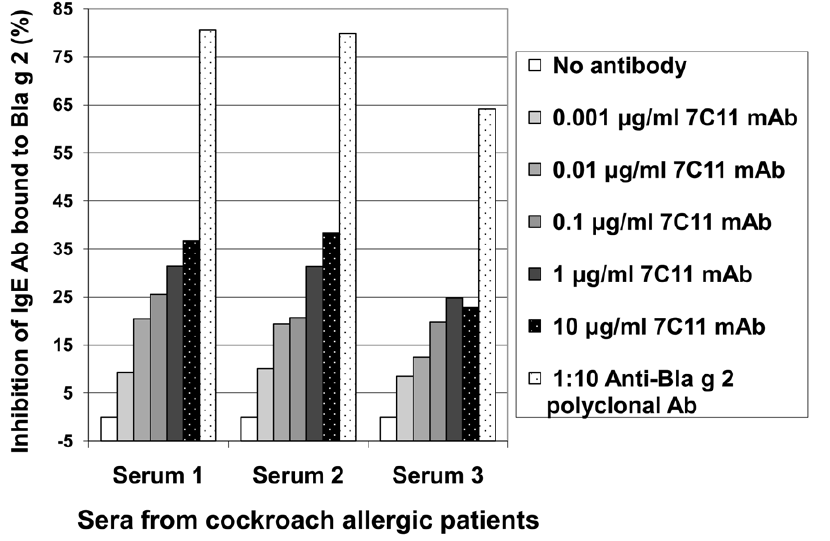
Figure 1. Overlap of 7C11 mAb and IgE antibody epitopes. Inhibition of IgE antibody binding to Bla g 2 by mAb 7C11 (0.001–10 m g/ml) and a rabbit anti-Bla g 2 polyclonal antibody.